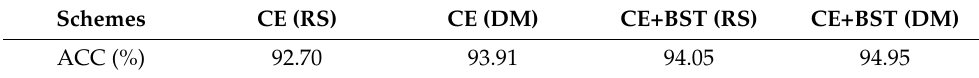
Figure 7. Loss curves of different training schemes for MobileNet-V3-Small on the Chest-1 dataset. Table 3. Accuracy of different training schemes for MobileNet-V3-Small on the Chest-1